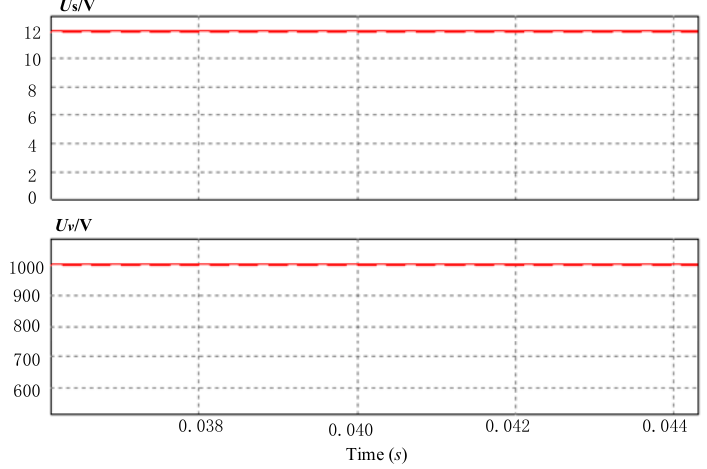
Figure 5. Simulation results of supply voltage Us is 12 V, clamp voltage Uv is 1000 V.